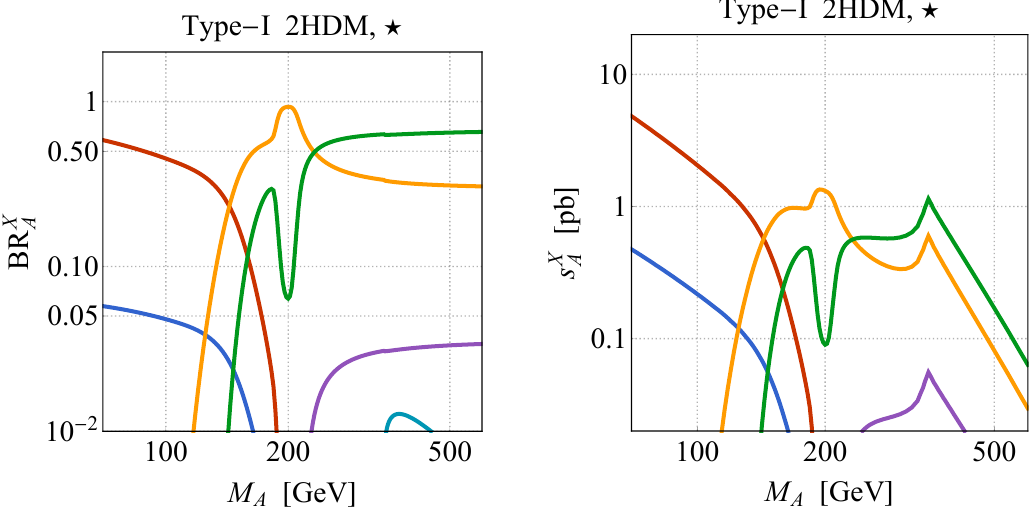
Figure 9 . Left: branching ratios of A into b (cid:22) b (red), (cid:28) + (cid:28) Zh (purple) and t (cid:22) t (cyan). Right: signal strengths for gg ! A ! X at states X are b (cid:22) b (red), (cid:28) + (cid:28) (cid:0) (blue), ZH (yellow), W (cid:7) H (cid:6) (green), Zh (purple) and t (cid:22) t (cyan). All results correspond to the benchmark scenario